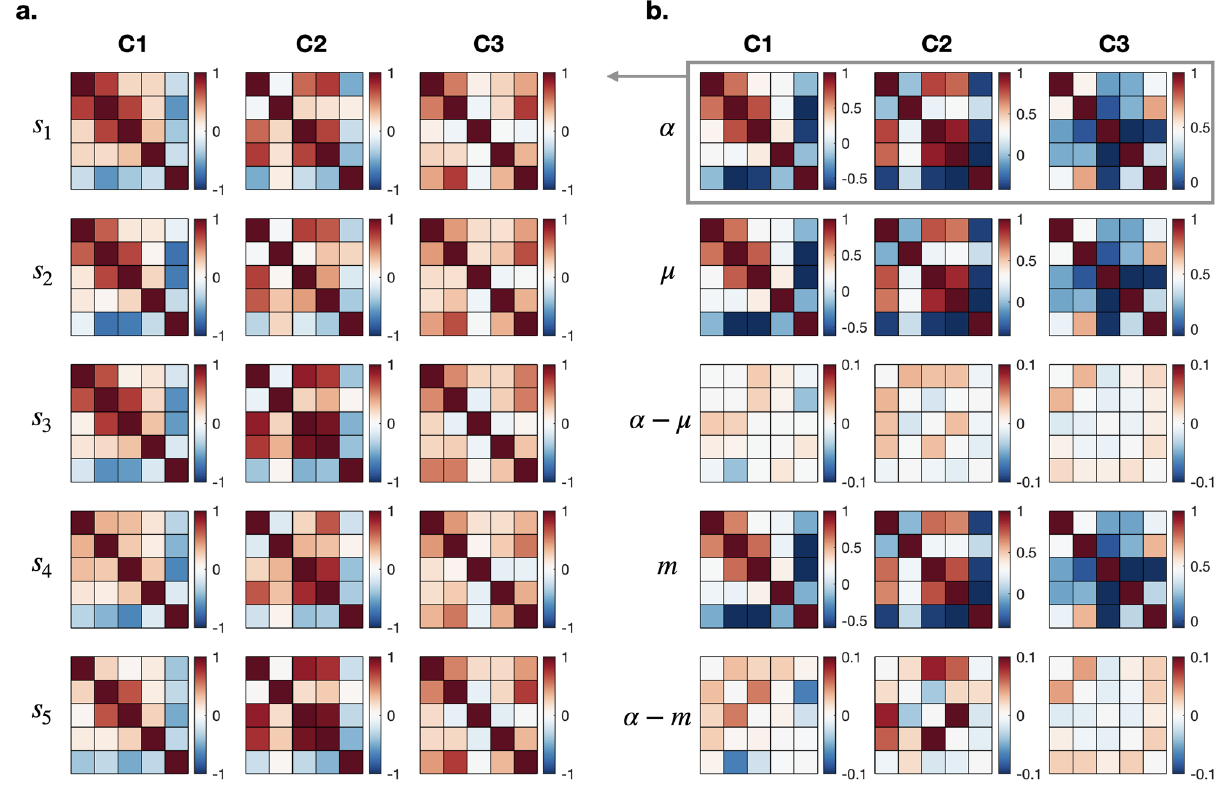
Figure 2. Comparison of the geometric mean ( µ ) and Euclidean average ( m ) for 30 samples generated from the three model correlation matrices (C1, C2, and C3) shown in the first row of ( b ), enclosed by a gray rectangle. Among the thirty samples slightly deviated from each model correlation matrix obtained by adding noise (the model matrix is denoted as α for C1, C2, and C3), five exemplary samples for each model correlation matrix are presented in ( a ). The third and fifth rows in ( b ) indicate the element-wise differences from the model correlation matrix ( α ). By visual analysis, greater differences are found in the Euclidean average compared to the geometric mean.